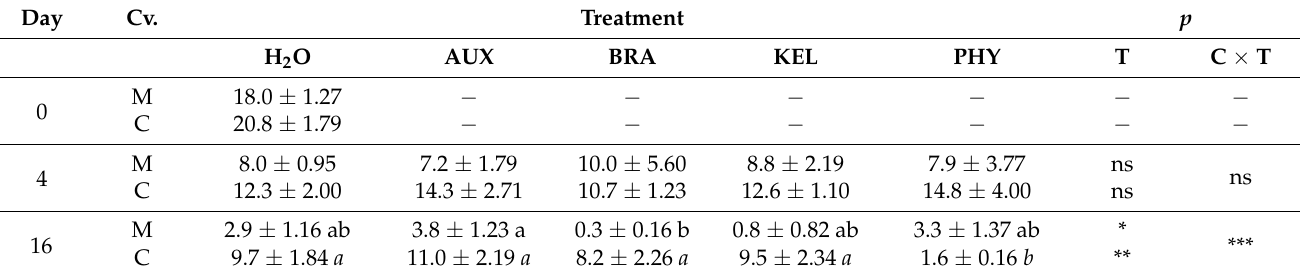
Table 1. Soluble sugars within the bark and the emerging callus of cv. ‘Michelangelo ® ’ (M) and ‘Cosmos ® ’ (C) cuttings, 0, 4, and 16 days after the treatments. Cuttings were treated with: H 2 O = distilled water; AUX = auxins; BRA = homobrassinolide; KEL = Kelpak ® ; PHY = Phylgreen. Two-way and one-way ANOVA p -values and Tukey’s post hoc comparisons are reported in the